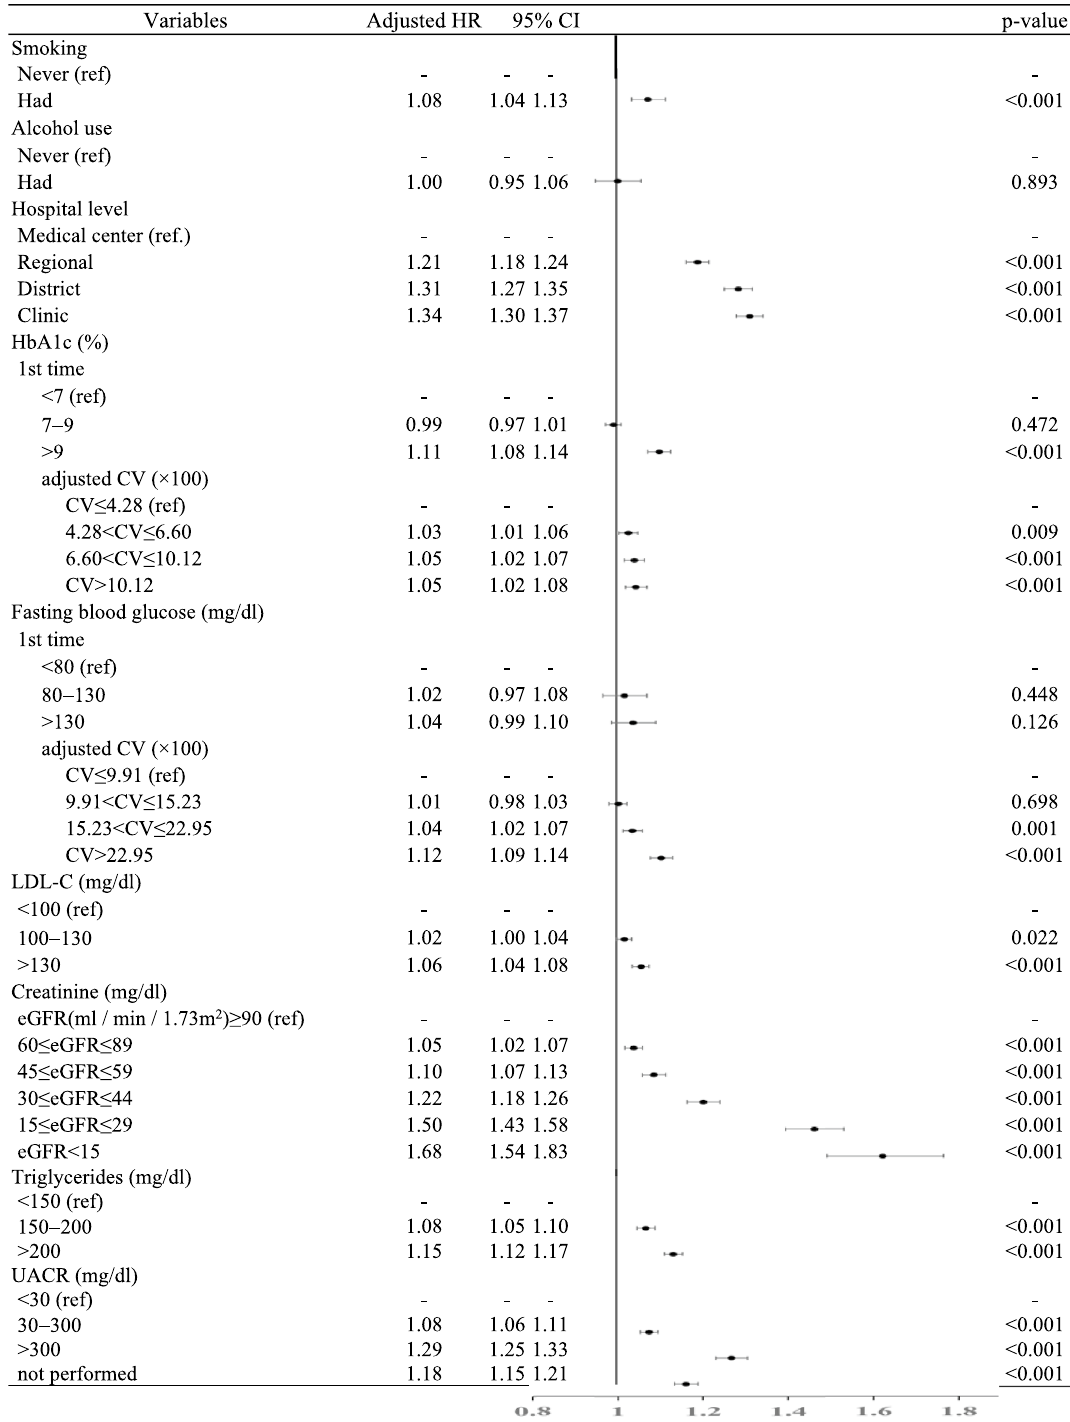
Table 3. The risk and influencing factors of incident cardiovascular disease in patients with T2DM. T2DM type 2 diabetes mellitus, CCI Charlson comorbidity index, DCSI diabetes complications severity index, BMI